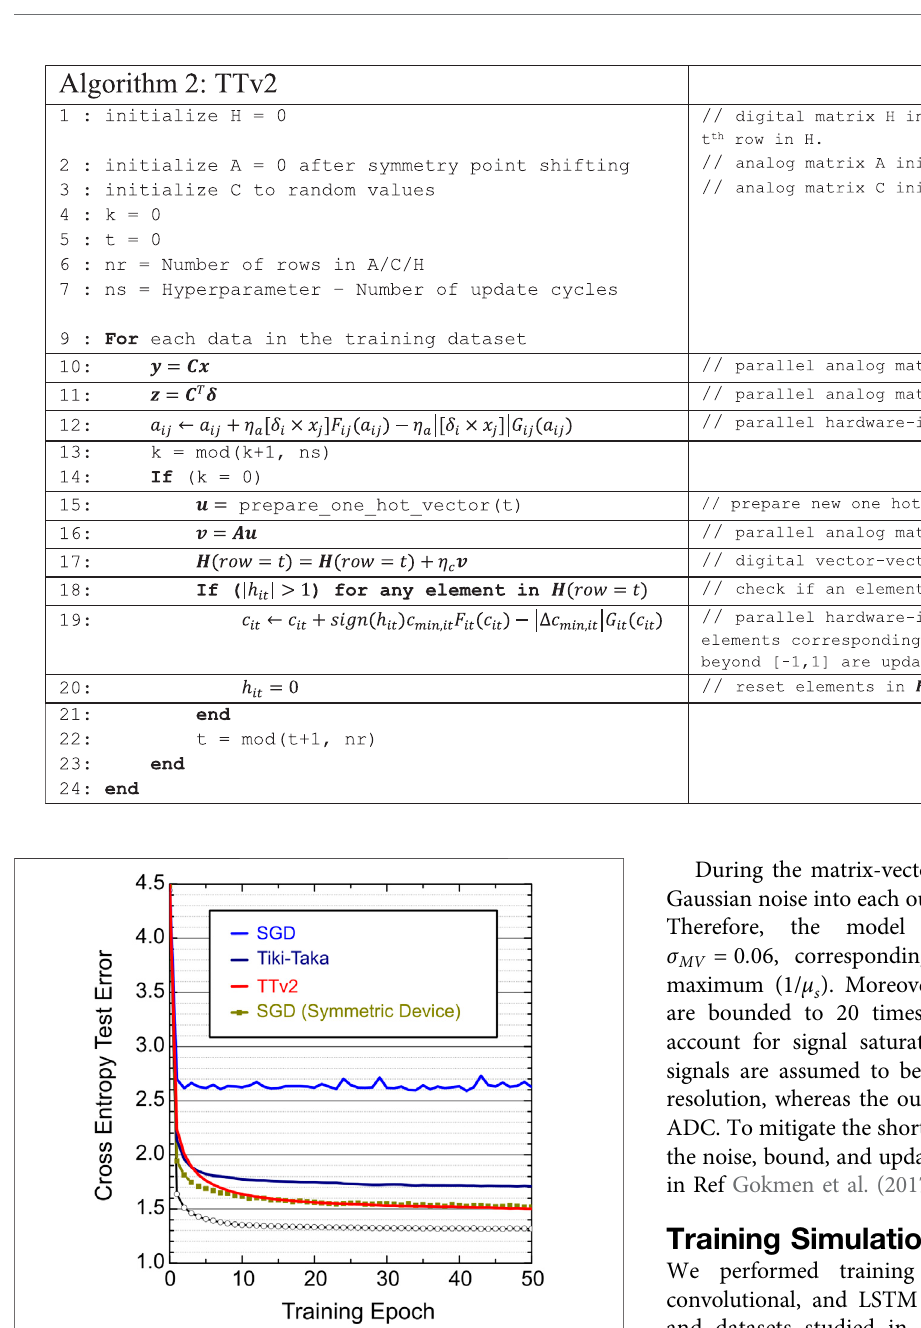
FIGURE 3 | LSTM training simulations for SGD, Tiki-Taka, and TTv2 algorithms. Different color curves use an array model with non-symmetric devices, μ Δ w (cid:1) 0 . 001 (corresponding to 1,200 states), and the multiplicative cycle-to-cycle update noise at σ cycle (cid:1) 0 . 3. The square symbols show the SGD training using linear and symmetric devices where all devices ’ slope parametersaresettozerowhileallotherarrayparametersremainunchanged. The open circles are the fl oating-point